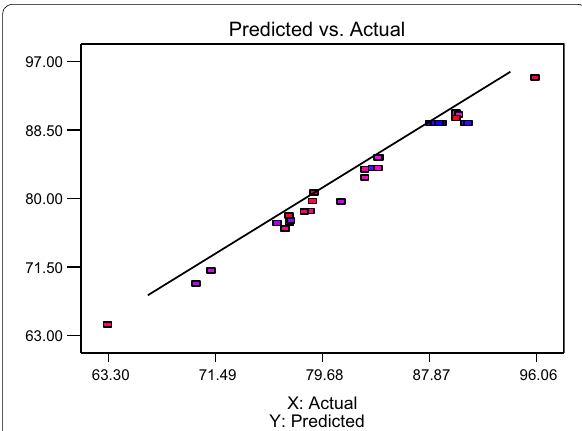
Fig. 3 The relationship between real values and predicted